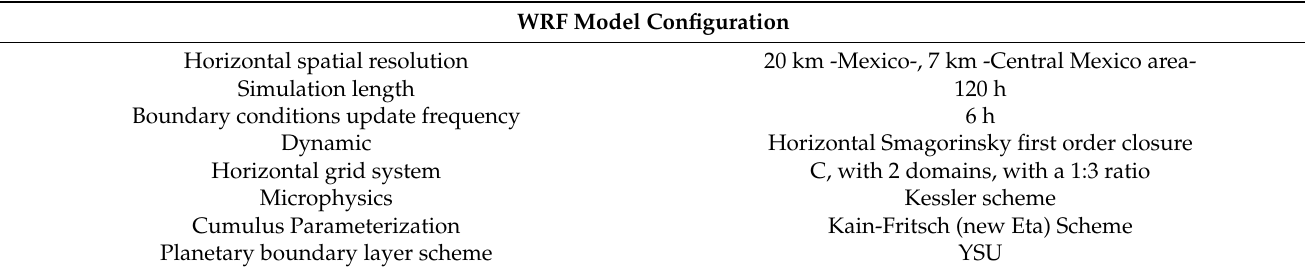
Table 2. Configuration of the WRF model.